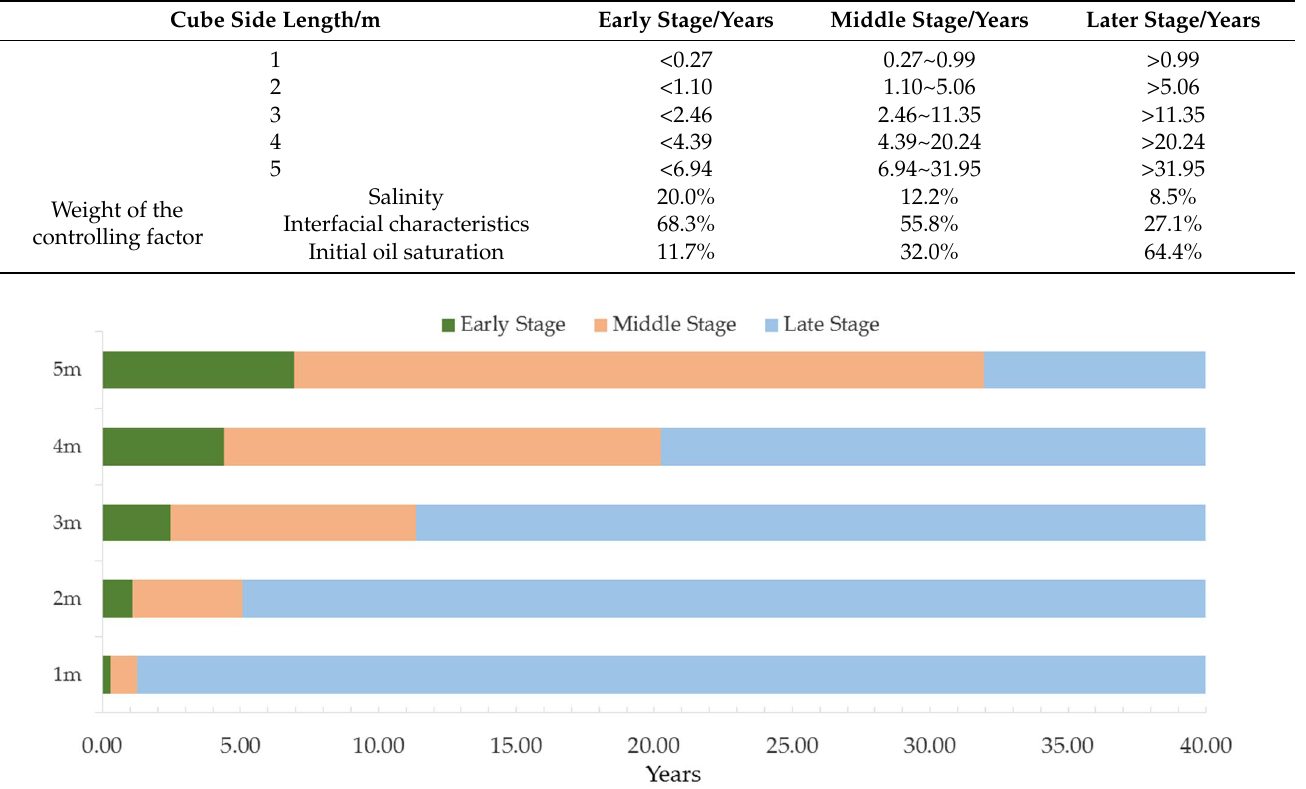
Figure 11. Periods of imbibition stages for different formation sizes.